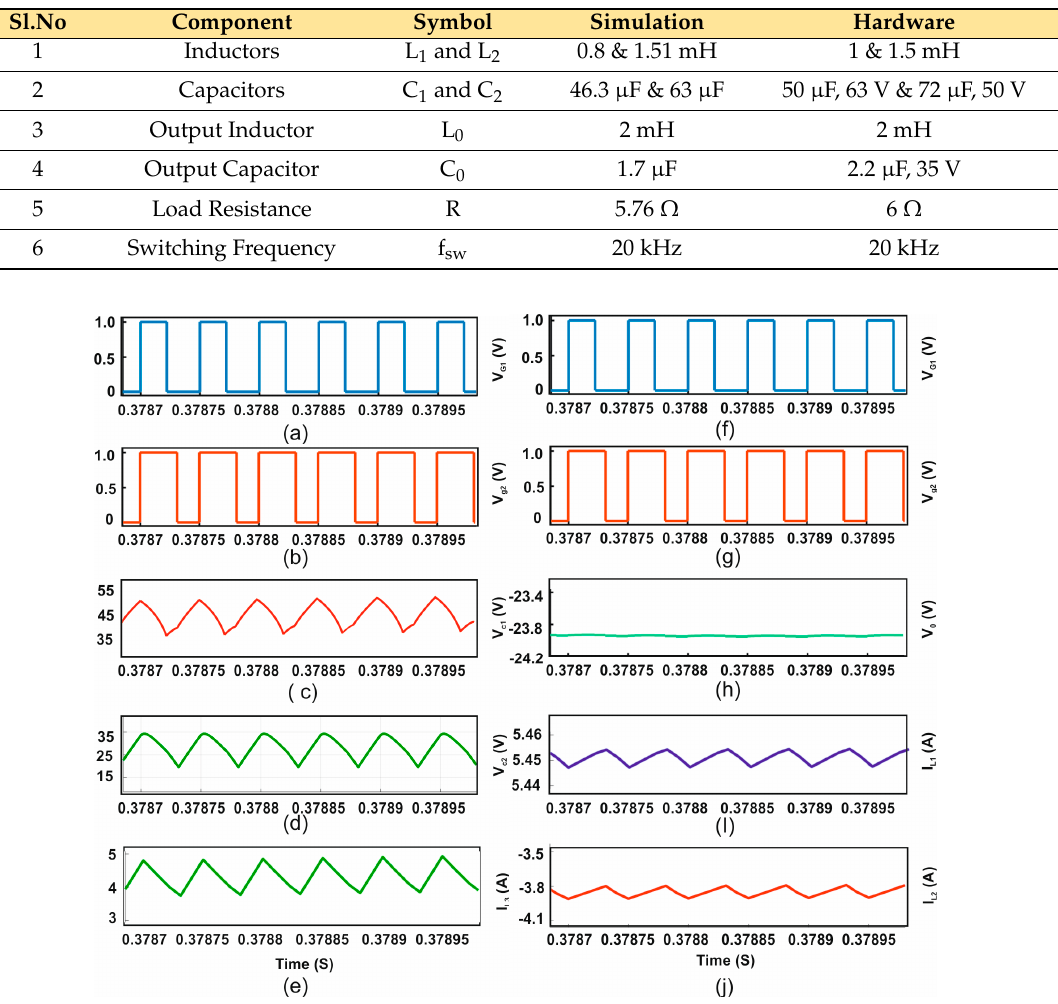
Table 2. Components of the proposed converter.